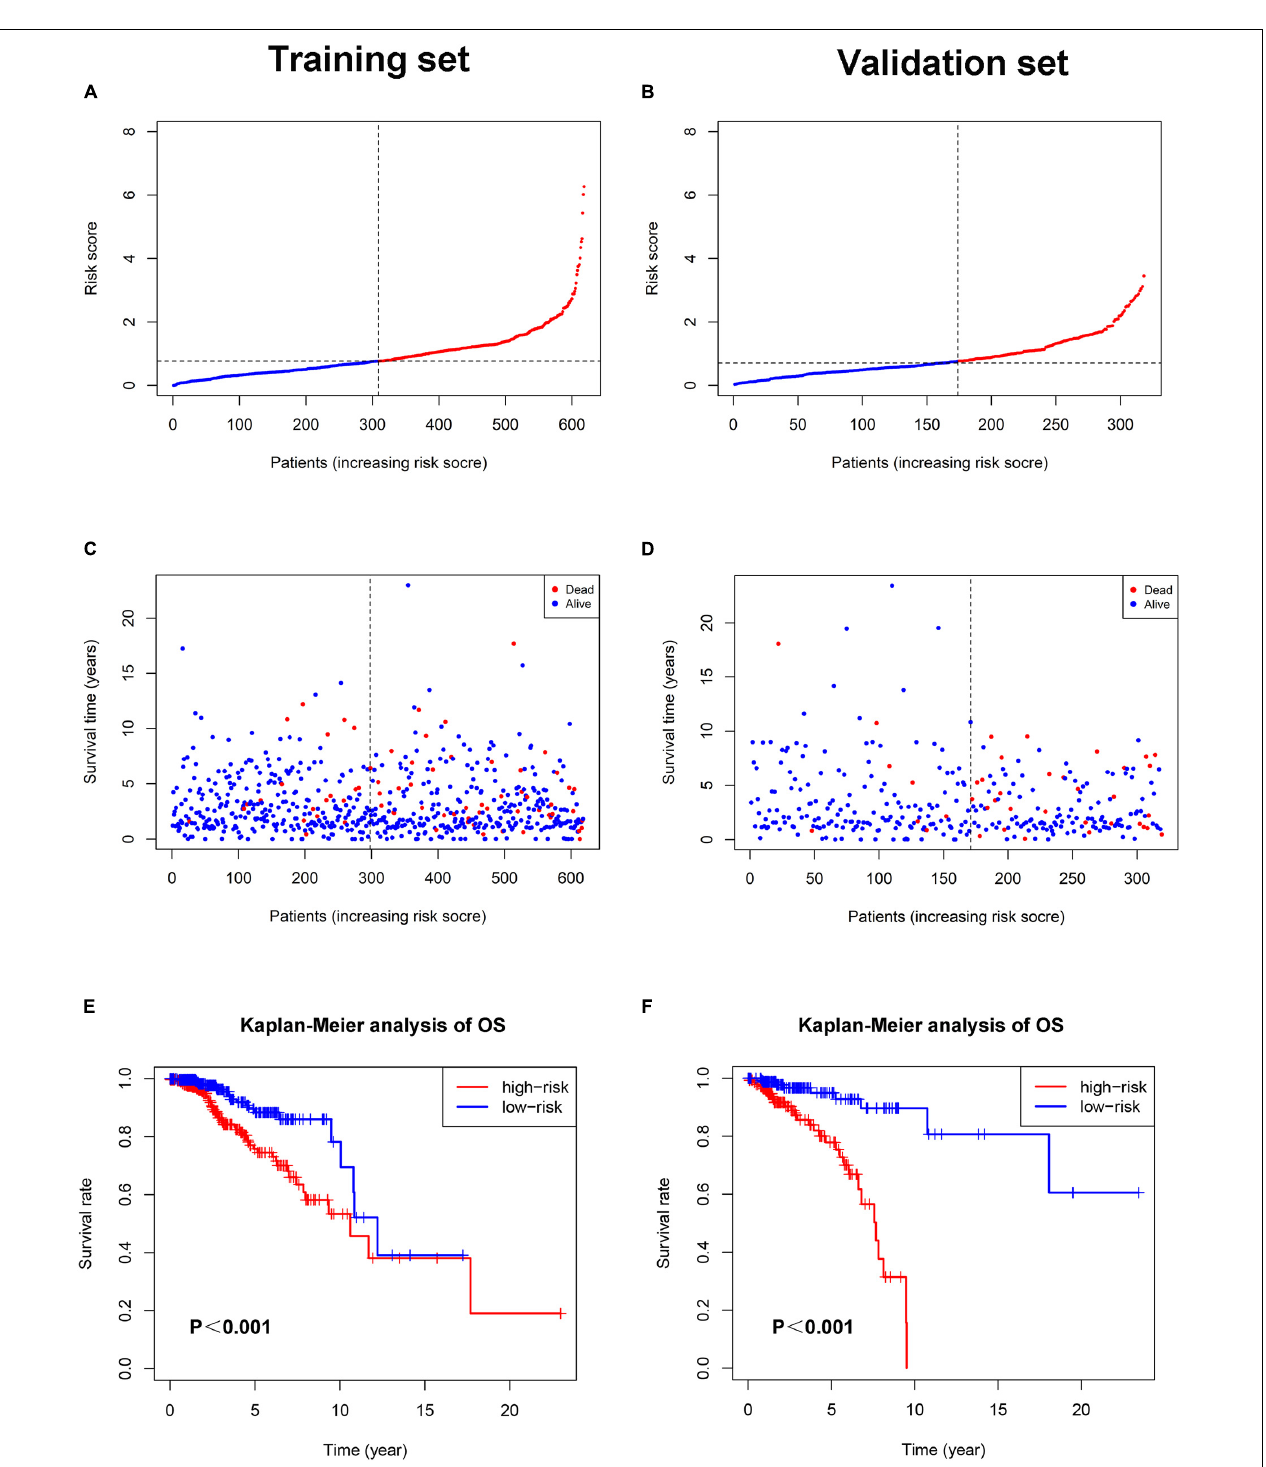
FIGURE 3 | The relationship between pyroptosis-associated lncRNA signature and prognosis in the training set and validation set. The distribution of the risk scores in the training set (A) and validation set (B) . The distributions of survival status, OS, and risk score in the training set (C) and validation set (D) . (E) Kaplan–Meier curves show the difference in OS between the high-risk and low-risk groups in the training set. (F) Kaplan–Meier curves show the difference in OS between the high-risk and low-risk groups in the validation set.